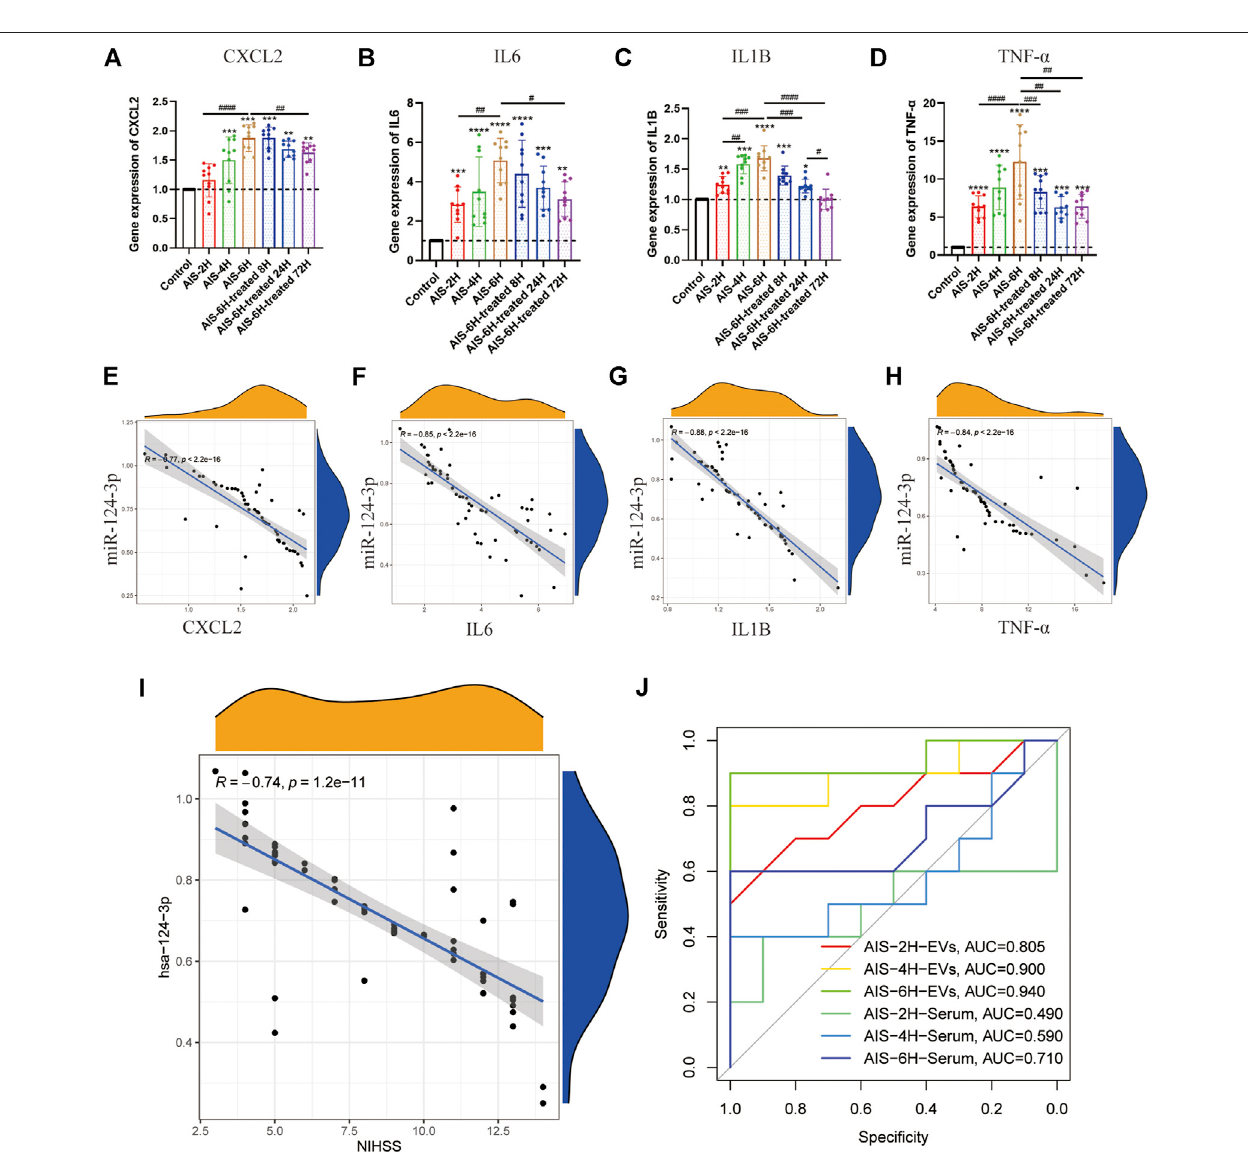
FIGURE3| Geneexpression of hsa-miR-124-3p inEVsnegatively correlatedwithin fl ammatoryfactors inserum and clinicalsymptoms. (A – D) Geneexpression of in fl ammatory factor ( CXCL2 , IL6 , IL1 β ,and TNF- α )analysisindifferentgroups at differenttimepoints. Difference tothe control group: * p < 0.05;** p < 0.01; *** p < 0.001; **** p < 0.0001, # Difference between groups: # p < 0.05; ## p < 0.01; ### p < 0.001; #### p < 0.0001; and one-way ANOVA with the Newman – Keuls multiple comparison test. (E – H) Correlation analysis of the gene expression between hsa-miR-124-3p in EVs and in fl ammatory factors. R : Pearson ’ s correlation coef fi cient, correlation coef fi cient | R | > 0.5, p < 0.05 was considered statistically signi fi cant. (I) Correlation analysis of the gene expression of hsa-miR-124-3p and the NIHSS. R : Pearson ’ s correlation coef fi cient, correlation coef fi cient | R | > 0.5; p < 0.05 was considered statistically signi fi cant. ( J) ROC curve of hsa-miR-124-3p expression in different groups for predicting the diagnosis of